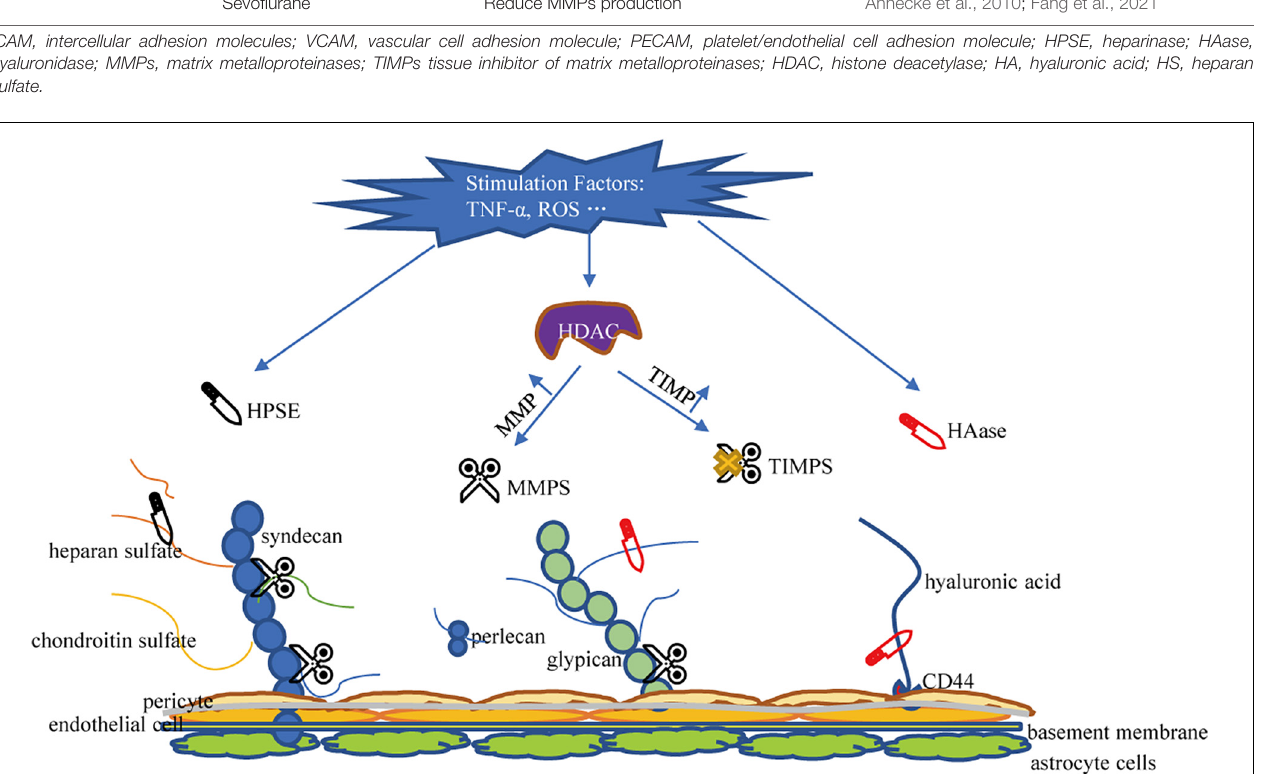
that the breakdown of cerebrovascular glycocalyx integrity may be related to ischemic brain diseases (Bell et al.,